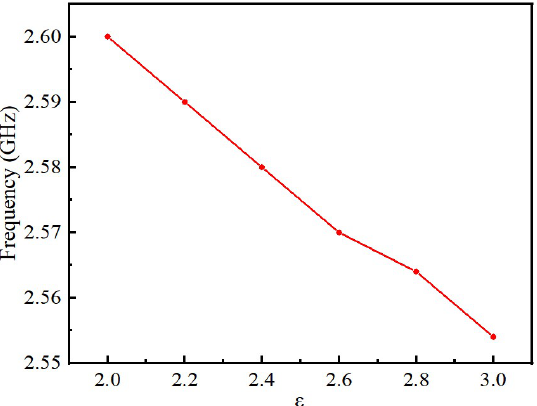
Figure 7. The relationship between the center frequency of sensor and the dielectric constant of microchannel.